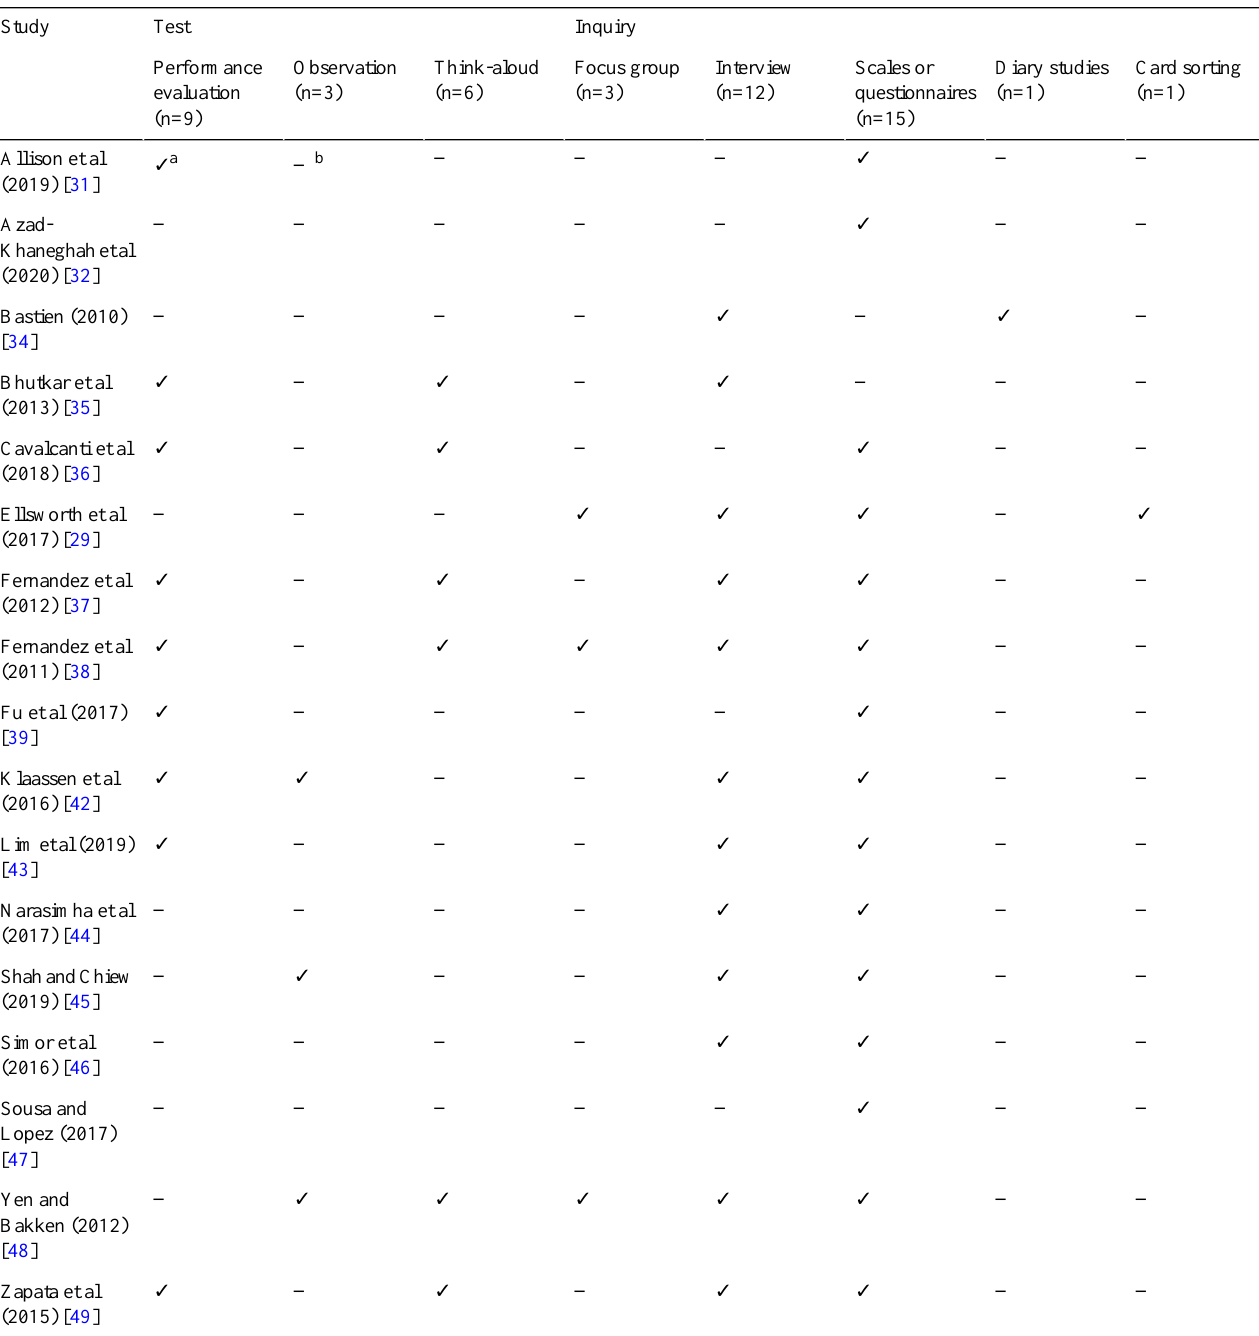
Table 3. Detailed techniques used for usability